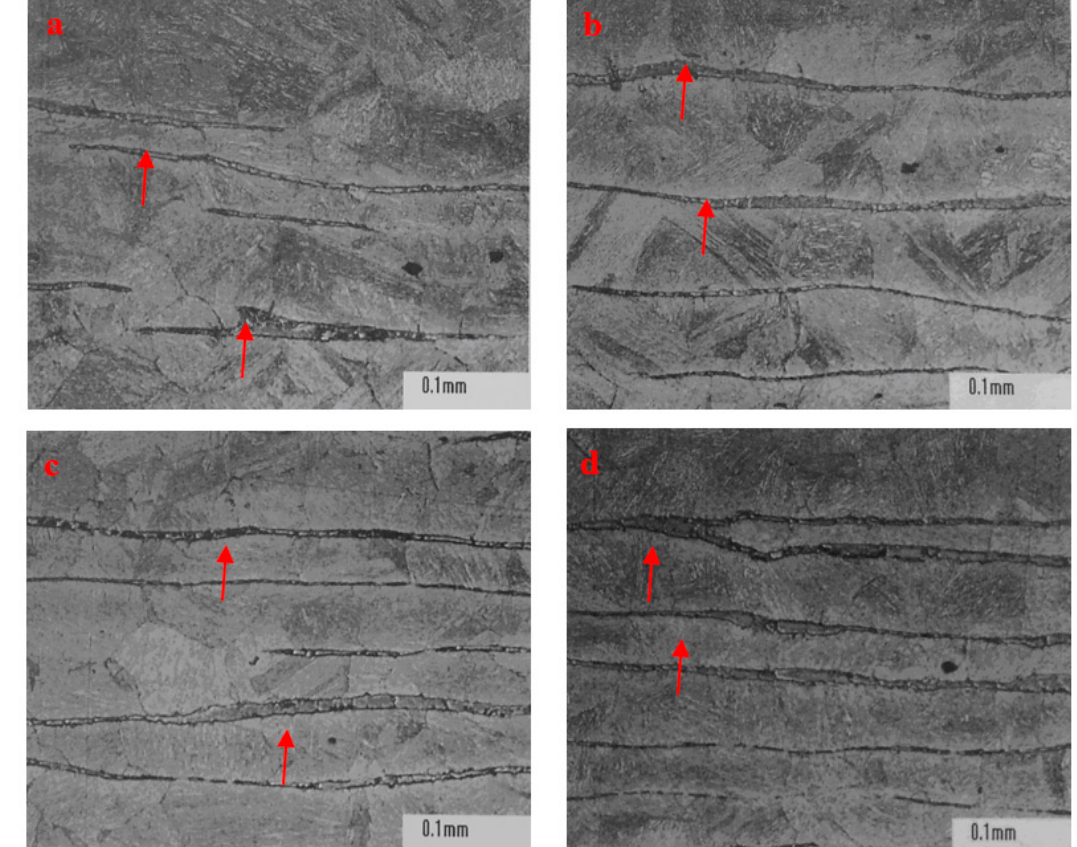
Figure 6. Distribution, density, and morphology of ferrite in the riser of P91 steel ingot. ( a ) surface zone; ( b ) ½ radius zone close to surface zone; ( c ) ½ radius zone close to core zone; ( d ) core zone.